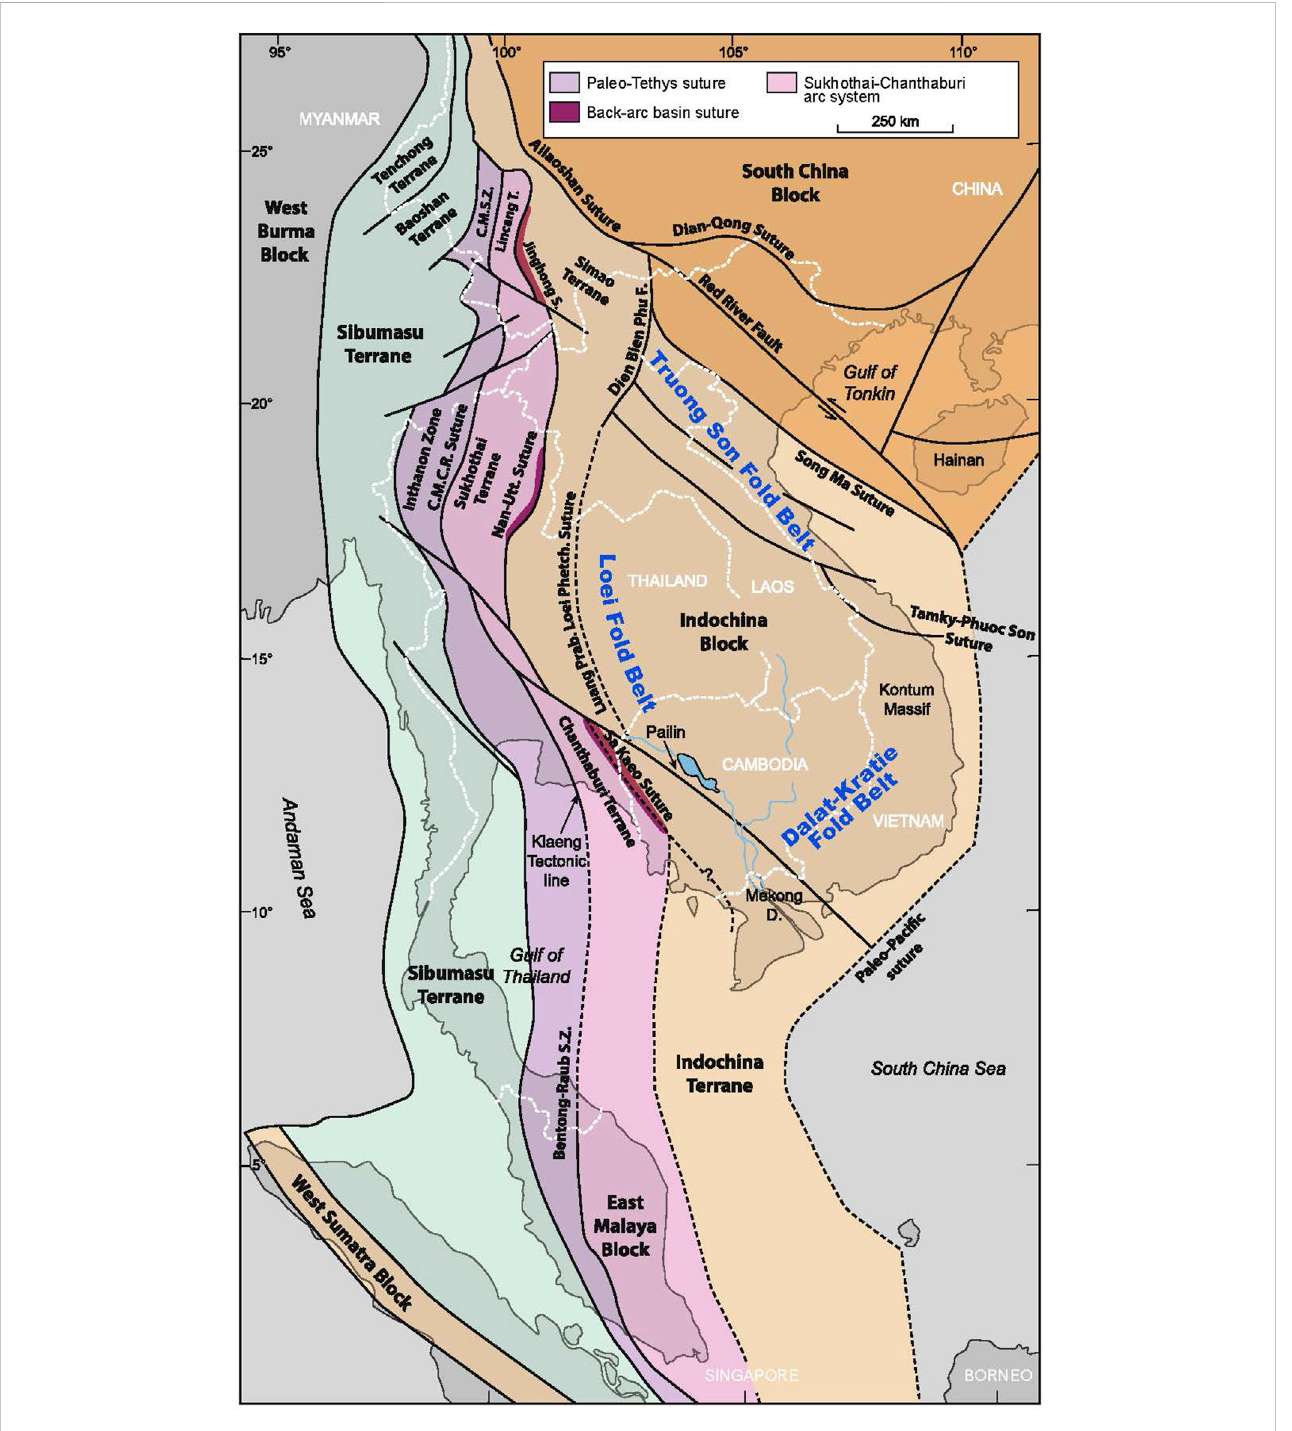
FIGURE 1 Tectonic subdivision of geological terranes of Southeast Asia showing the location of the Dalat-Kratie Fold Belt (modi fi ed from Metcalfe, 2017).